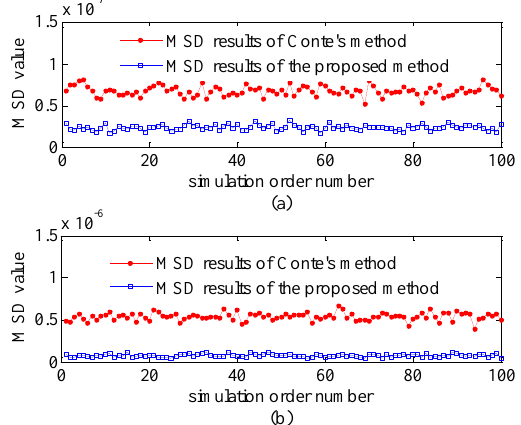
Figure 5. Mean squared difference (MSD) results of goodness of fit when utilizing different methods. ( a ) Gamma distribution ( b ) Inverse Gamma distribution.